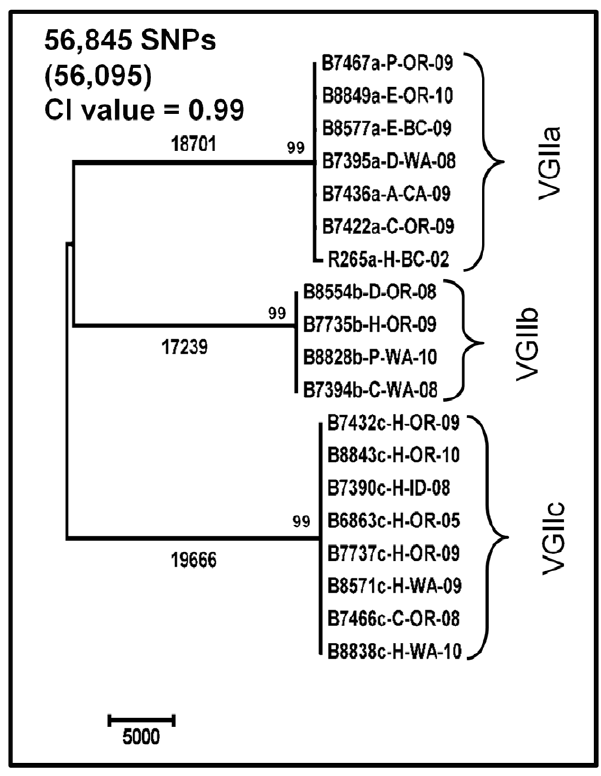
Figure 2. Phylogenetic analysis of WGST data from C.gattii VGII molecular type isolates. Maximum parsimony phylogenetic analysis was performed in MEGA4 on WGST SNP data from 18 VGII C. gattii genomes using the R265 whole genome sequence as the reference for SNP discovery (R265a-H-BC-02). The analysis found 76 most parsimo- nious trees, one of which is shown. The total number of SNPs included in the analysis is indicated (number of parsimonious SNPs in parentheses) as is the consistency index (CI) as calculated by MEGA4. Bootstrap values less than 50% are not shown. The tree shown is rooted on the mid-point. Branch lengths as calculated by MEGA4 are indicated above the three major branches. All other branch lengths are less than 500. The taxa nomenclature include a unique four digit identifier, the molecular subtype (a, b or c), the source of the isolate (A=alpaca, C=cat, D=dog, E=environmental, H=human and P=porpoise), the location of origin (BC=British Columbia, CA=California, ID=Idaho, OR=Oregon and WA=Washington state), and the year of collection. For example, B7395a-D-WA-08 indicates that isolate B7395 is a VGIIa subtype collected from a dog in Washington state in